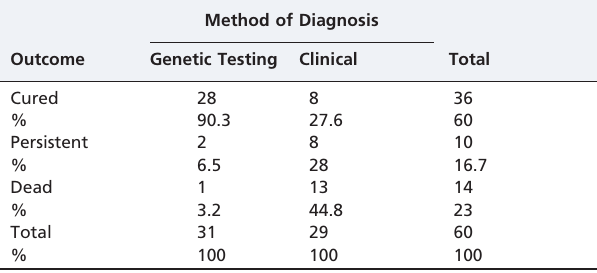
Fisher’s exact test